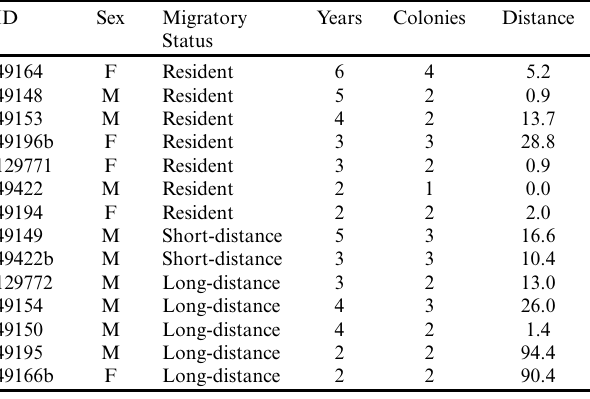
Table 2 . The number of years a Reddish Egret ( Egretta rufescens ) nested, number of nesting islands used, and the mean distance (km) between nesting colonies during